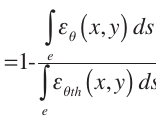
Observed region 1423 × 1123 µ m (512 × 480) According to Eq. (2), ∆ d = 0.447 microns